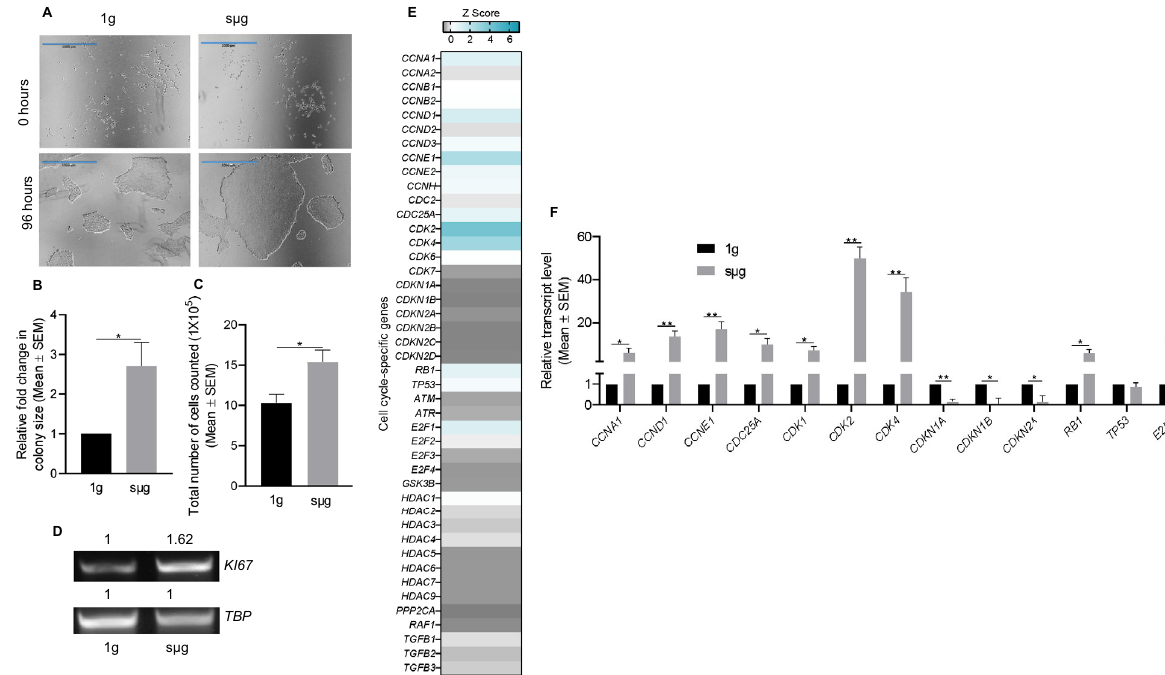
Fig. 4 Simulated microgravity (sµg) enhances the proliferation of hPSCs. A Representative micrographs of hPSC colonies cultured under s μ g and 1g conditions. Scale bars, 1000 µm. B Graphs indicating signi fi cant fold change difference in hPSC colonies area after 96 h of culture under smg and 1g conditions. C Graph comparing the total cell number of hPSCs after 96 h of culture under s μ g and 1g conditions. D Representative gel band images of rt-PCR analysis for the cell proliferation gene Ki67 in hPSCs after 96 h of culture under s μ g and 1g conditions. The mRNA expression of TBP was used to show equal loading and to quantify the relative differences in expression, as indicated above each band. E Heat map showing the relative mRNA levels of 44 human cell cycle-associated genes in hPSCs culture under s μ g for 96 h in relation to cells cultured in 1g condition. F RT-qPCR analysis was used to verify the expression of selected genes tested in the gene array assay. * p < 0.05, ** p < 0.005 ( n = 3; unpaired t test). Error bars in graphs represent the SEM of the